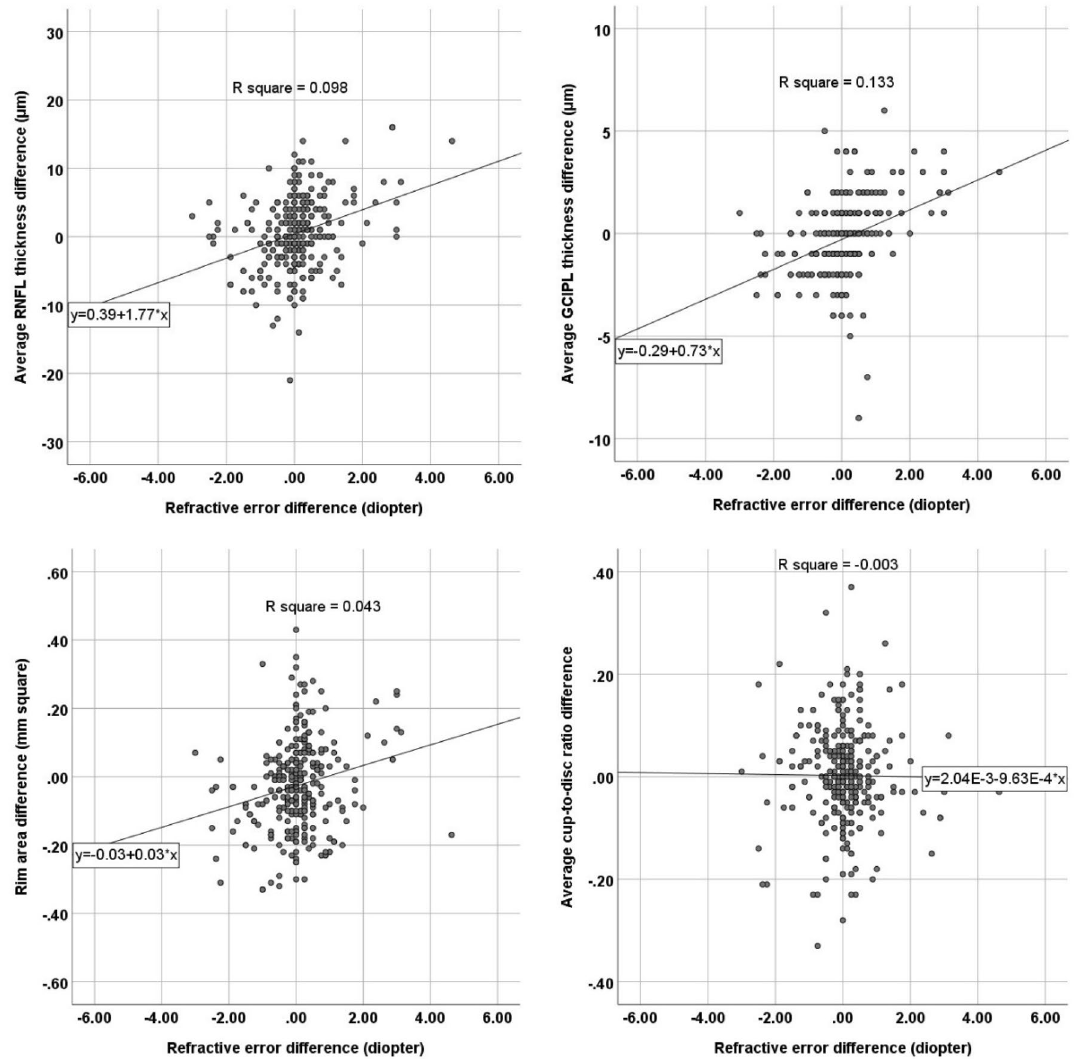
Figure 2. Scatter plot presenting the correlation between the interocular refractive error difference (right eye– left eye) and interocular differences in the average retinal nerve fiber layer (RNFL) thickness, average ganglion cell-inner plexiform layer (GCIPL) thickness, rim area, and cup-to-disc ratio measured by optical coherence